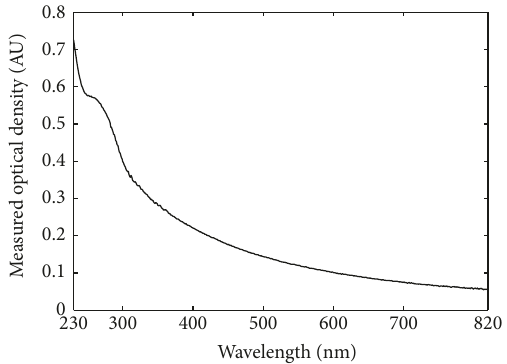
Figure 1: Multiwavelength transmission spectra of puri fi ed E. coli .